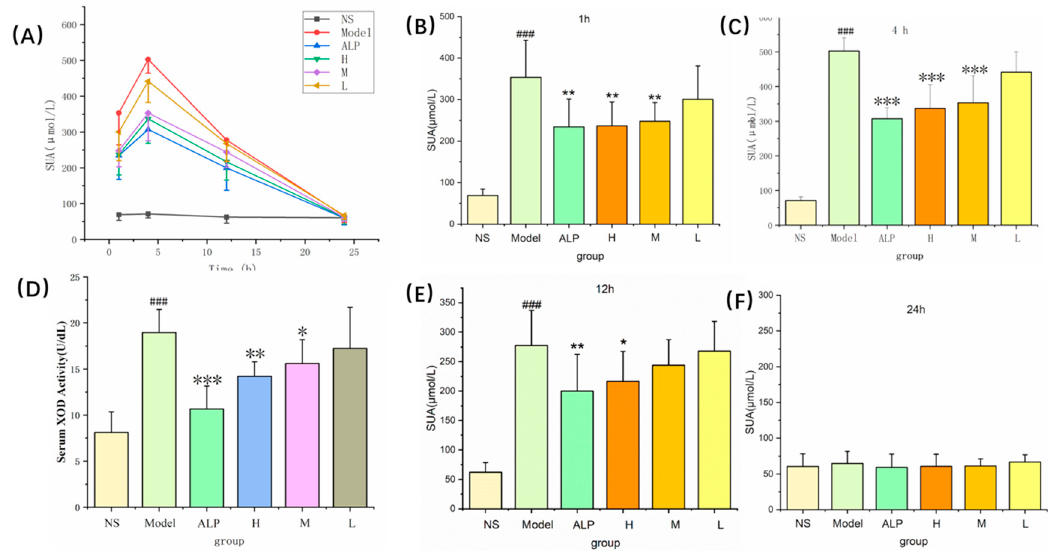
Figure 5. Effects of PLR-CDs on serum uric acid levels for 24 h ( A ) and serum xanthine oxidase (XOD) activity for 1 h ( D ) in hyperuricemic rats. NS and Model represent normal control group and model group, respectively; ALP, H, M, and L indicate rats treated with allopurinol and high, medium, and low doses, respectively, of PLR-CDs. Serum uric acid level was measured at 1 h ( B ), 4 h ( C ), 12 h ( D ), and 24 h ( E ). # p < 0.05, ## p < 0.01, ### p < 0.001 when compared to NS group; ∗ p < 0.05, ∗∗ p < 0.01, ∗∗∗ p < 0.001 when compared to the ALP group.